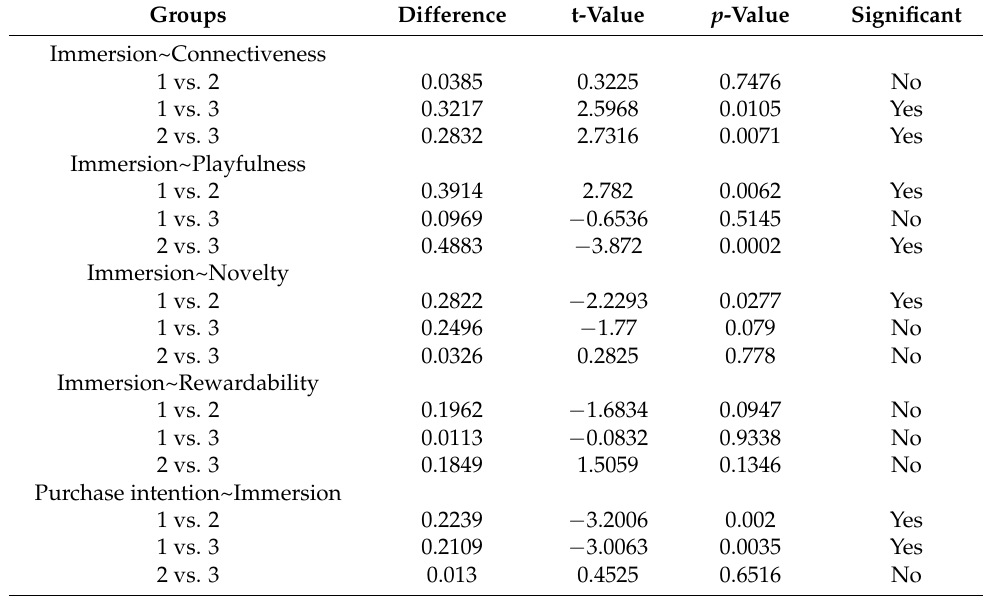
Table 4. Multi-group analysis